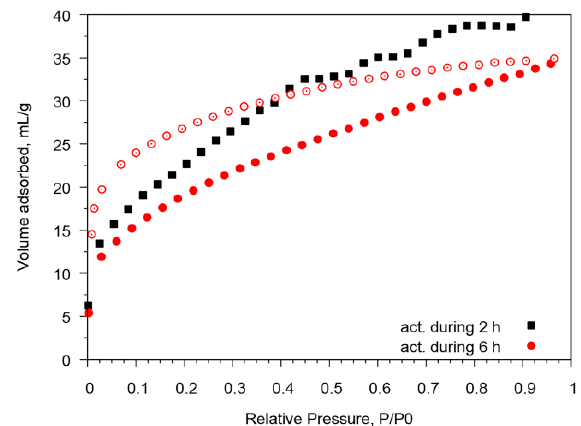
Figure 10. CO 2 adsorption (•, ▪ )-desorption ( ◦ ) isotherms at 195 K on 1 activated during 2 and 6 h s. Table 2. The parameters of porous structure of compound 1 .